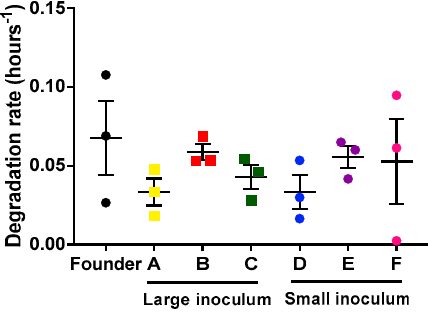
Figure 3. Mycobacteriophages degradation rates of the founder and evolved lines. Founder: Black. Large inoculum: ( A ) Yellow, ( B ) red, ( C ) green. Small inoculum: ( D ) Blue, ( E ) purple, ( F ) pink. Dots show the experimental replicates, and error bars indicate the SEM ( n = 3).